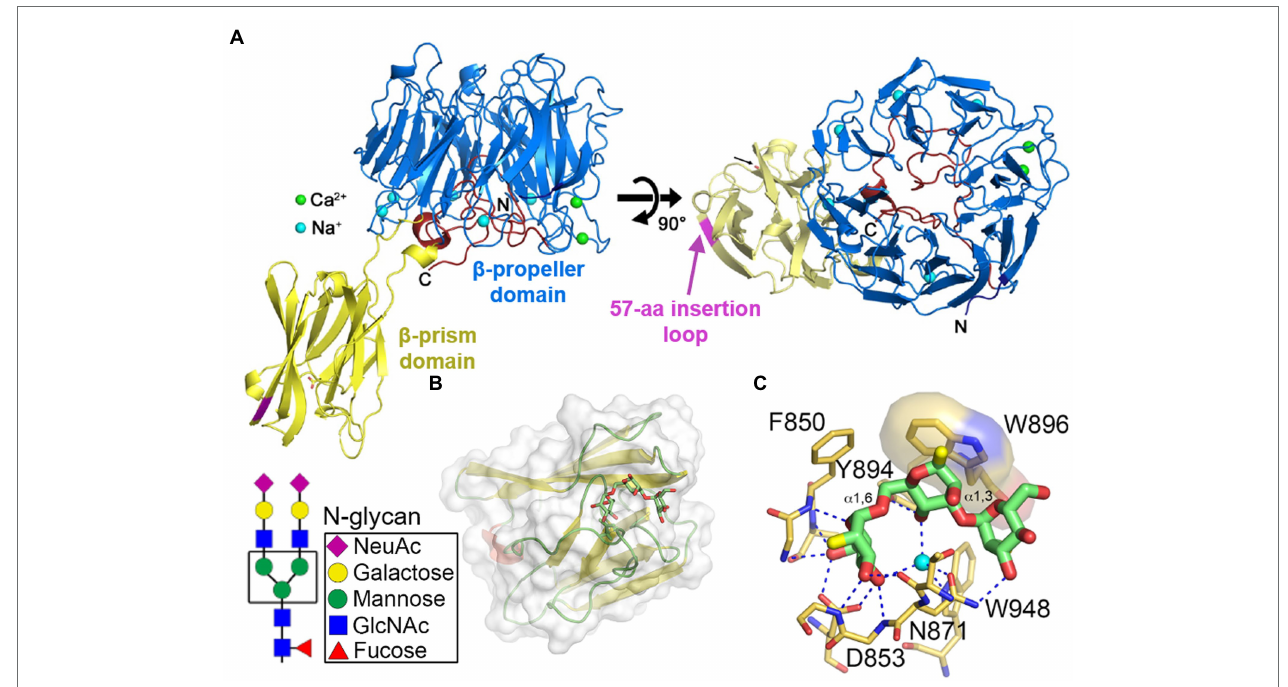
(PDB:6MLT). The 57-amino acid insertion in the β -prism domain FIGURE 5 | Molecular mechanism of V. cholerae biofilm adhesion. (A) Crystal structure of Bap1 Δ 57 was removed for crystallization (indicated by magenta segment). (B) Crystal structure of the second β -prism domain of RbmC bound to mannotriose (PDB:5V6F). Inset shows the core N-glycan structure. (C) Close-up view of the binding pocket and key residues involved in glycan binding in the β -prism. Panel (A) is adapted with permission from Kaus et al. (2019); panels (B,C) are adapted with permission from De et al.